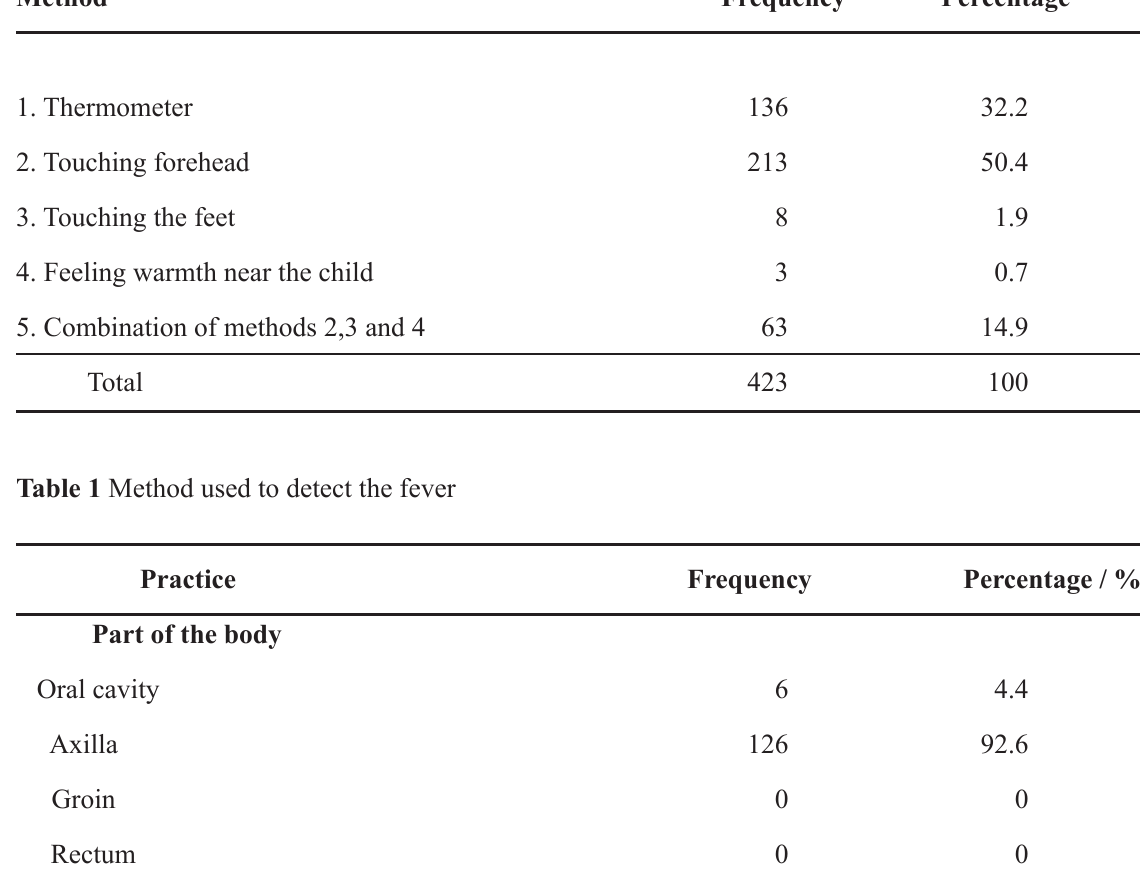
Table 1 Method used to detect the fever Method